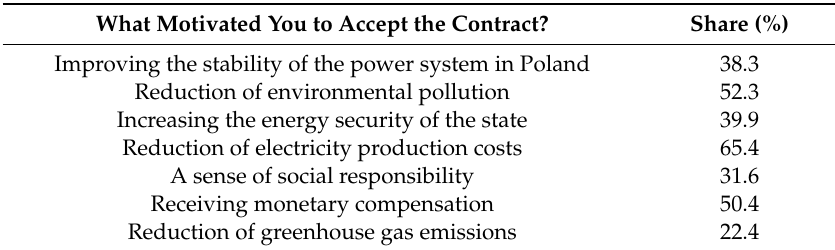
Table 4. The reasons for accepting the